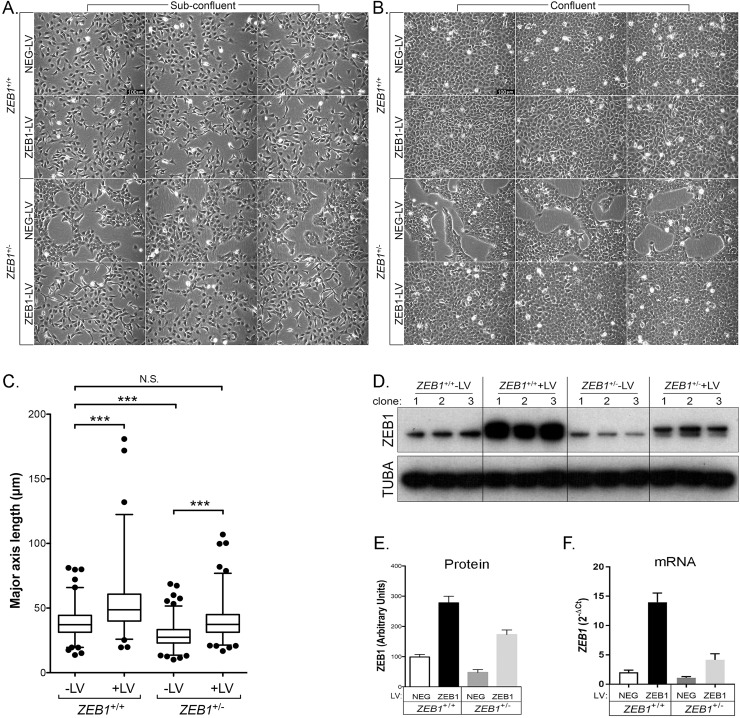
ZEB1 regulates CEnC morphology in a manner consistent with EMT.(A) Sub-confluent cultures established 1 day after seeding of the two control and two ZEB1 transgenic CEnC lines with each genotype (ZEB1+/+ -LV, ZEB1+/+ +LV, ZEB1+/- -LV and ZEB1+/- +LV) represented by three independent clones (individual images). (B) Confluent cultures of cell line clones shown in (A) established 3 days post-seeding. Scale bars in (A) and (B) represent 100μm distance. (C) Box and whiskers plot showing the cell major axis length (MAL) distribution for each of the CEnC lines. MAL was used to assess cell morphology as a measure of cell state phenotype. Note that a relatively short MAL is indicative of an epithelial-like phenotype, while a relatively long MAL is indicative of a mesenchymal-like phenotype. Box encompasses 50% of data points, line in box is the median of the MAL and whiskers encompass 98% of data points (n = 357–688). Comparisons of the MAL for the CEnC lines were performed using one-way ANOVA with post-hoc Tukey test. ***, P<0.001; N.S., not significant (p>0.05). (D) Western blot showing ZEB1 levels in the twelve clones (3 independent clones per genotype) used in this study. Alpha-tubulin (TUBA) was used as a loading control. (E) ZEB1 protein abundance was determined by densitometric analysis of Western blot data shown in (D). Quantification data are represented as mean ±SEM (n = 3). Bar graphs showing ZEB1 protein (E) and ZEB1 mRNA (F) abundances in the four CEnC lines. ZEB1 transcript abundance was measured relative to GAPDH and plotted as 2-ΔCt.